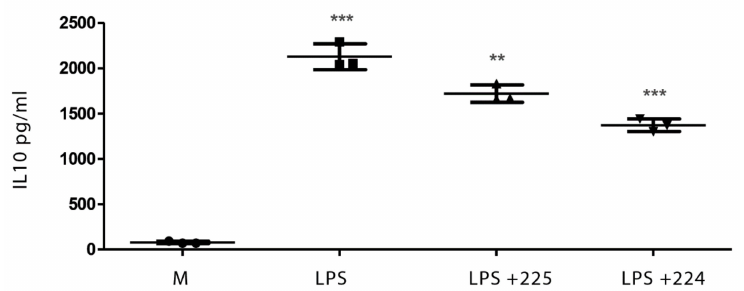
Figure 5. The e ff ect of UK propolis on IL-10 production in LPS-stimulated macrophages; n = 3 ** p value < 0.01 *** p value < 0.001. Comparisons of LPS against medium and LPS + propolis samples 224 and 225 against LPS.